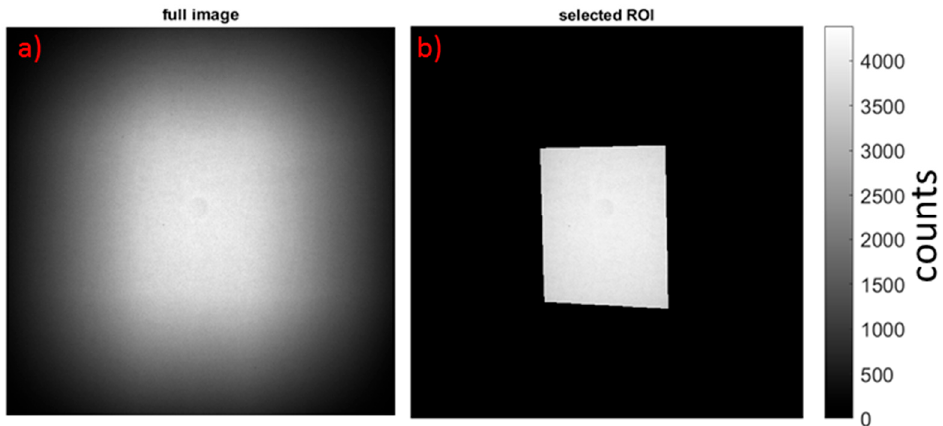
Figure 3. ( a ) Full acquired radiograph showing beam profile; ( b ) Region of interest (ROI) selected for evaluation.